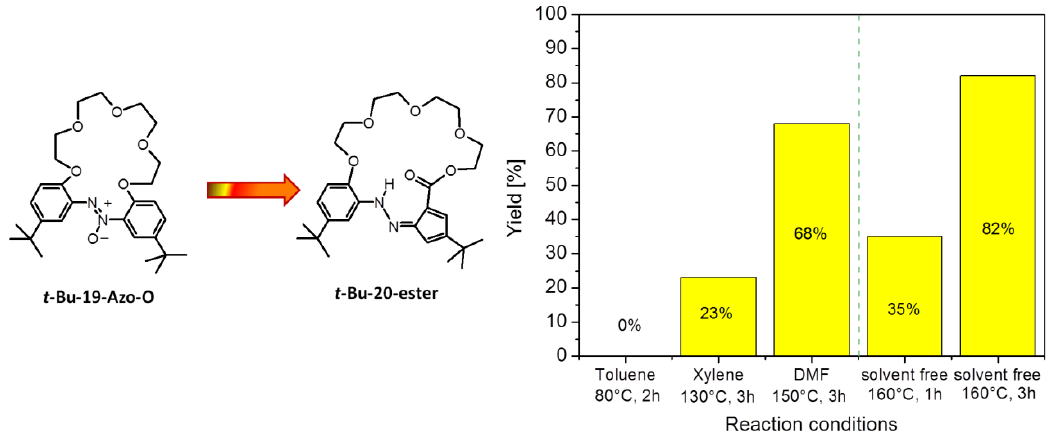
Figure 2. Yields of t -Bu-20-ester in thermal rearrangement of t -Bu-19-Azo-O